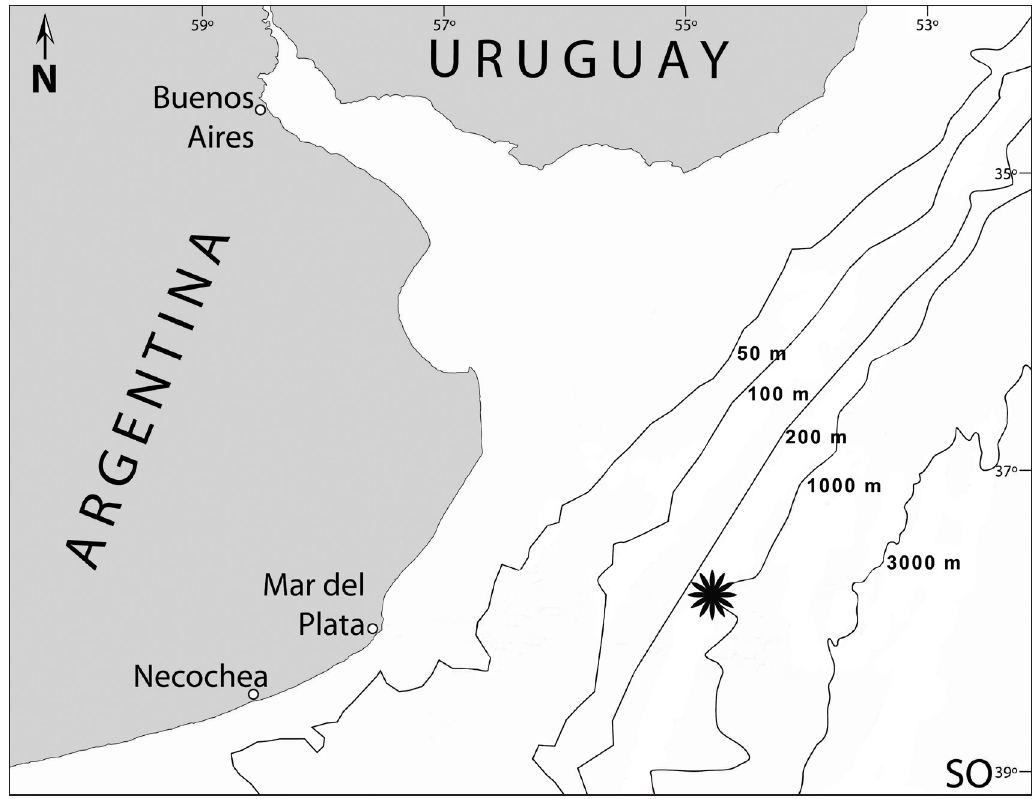
Figure 1. Study area in the SW Atlantic. The asterisk shows the sampling